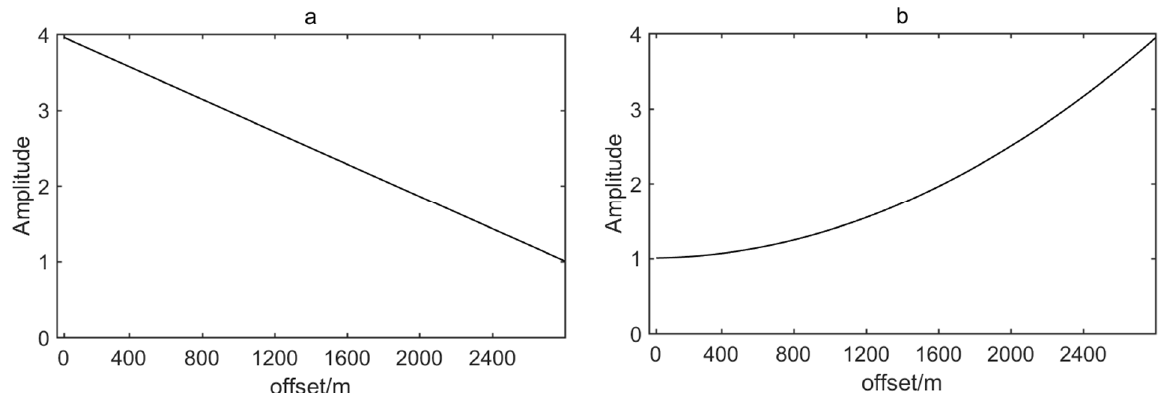
Figure 4. ( a ) AVO of the reflection at 500 ms; ( b ) AVO of the reflection at 900 ms. To test the data reconstruction performance, we created some empty channels in the synthetic data, as shown in Figure 5a. We used the waveform Radon transform (WRT) and CGRT to reconstruct the data gather. The Radon panel results in Figure 5b,c show that the resolution of the WRT in the Radon panel was higher than the CGRT, and the WRT waveform was closer to the Ricker wavelet. Figure 6 shows the inverse transform result and its residual.